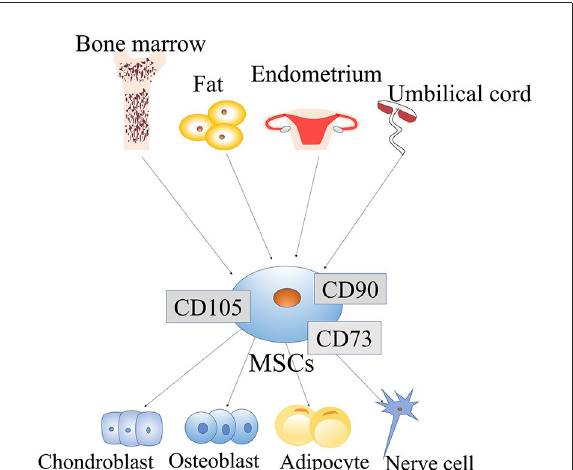
FIGURE1 Origin and differentiation of mesenchymal stem cells (MSCs): MSCs come from a wide range of sources, such as the bone marrow, fat, endometrium, and umbilical cord. MSCs have the potential for self-renewal and multi-lineage differentiation. They can differentiate into various lineage of tissues, include chondroblasts, osteoblasts, adipocytes, and neuronal cells. MSCs are easily obtainable from a wide range of sources, and their ability to differentiate multi-directionally allows them to be applied in a variety of